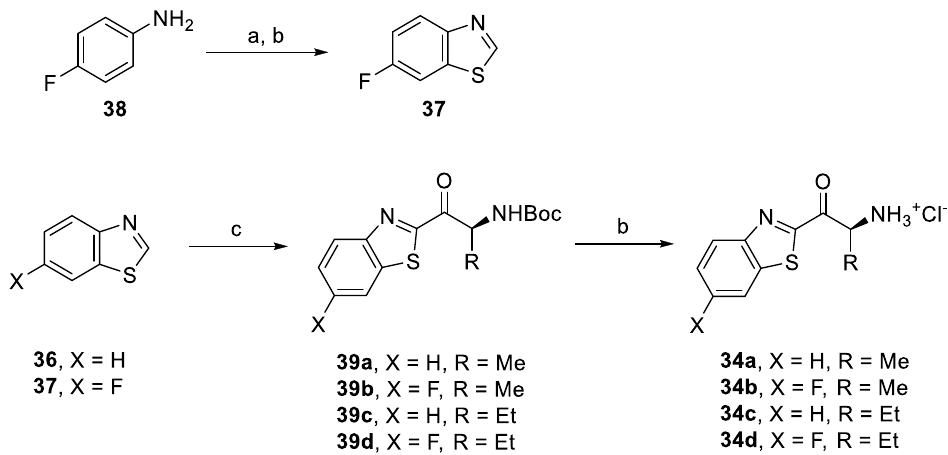
Figure 12. Synthesis of triazole derivatives based on SAR. Reagents and conditions: (a) KSCN, Br 2 ,